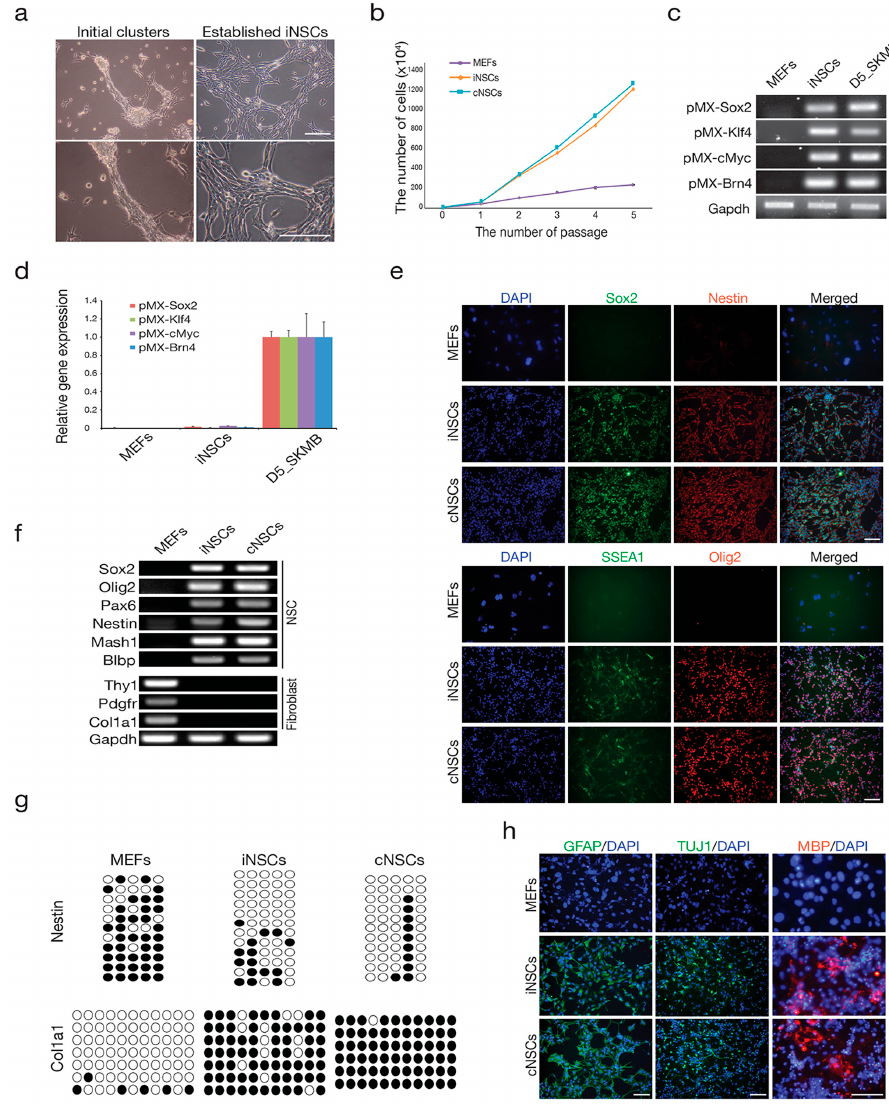
Figure 1. Direct conversion of fibroblasts into induced neural stem cells (iNSCs) ( a ) Morphology of the initial iNSC clusters at four weeks after induction of reprogramming (left) and established iNSC cell lines at passage 10 (right). Scale bars = 100 µm; ( b ) proliferation of iNSCs. Cells (1 × 10 5 ) were passaged every two days on the wells of 12-well plates; ( c ) iNSCs showed integration of retroviral transgenes encoding Sox2 , Klf4 , cMyc , and Brn4 (SKMB); ( d ) expression levels of retroviral transgenes in the iNSCs at passage 15. The expression levels are normalized to those of mouse embryonic fibroblasts (MEFs). Error bars indicate the standard derivation of triplicate values. d5_SKMB, Day 5 after SKMB retroviral transduction; ( e ) immunofluorescence microscopy images of iNSCs and control NSCs (cNSCs) using antibodies against Sox2/Nestin (upper panel) and Olig2/SSEA1 (lower panel). MEFs and cNSCs were used as the negative and positive control, respectively. Scale bars = 100 µm. ( f ) RT-PCR analysis of markers for NSCs and fibroblasts in the established iNSC line; ( g ) the DNA methylation status on the second intron of Nestin and the promoter region of Col1a1 in MEFs, cNSCs, and iNSCs was assessed by bisulfite sequencing PCR. Open and filled circles represent unmethylated and methylated CpGs, respectively; ( h ) in vitro differentiation potential of iNSCs into astrocytes, neurons, and oligodendrocytes, as shown by immunostaining with antibodies against glial fibrillary acidic protein (GFAP), Class III β -tubulin (Tuj-1), and myelin basic protein (MBP), respectively. Scale bars = 100 µm.